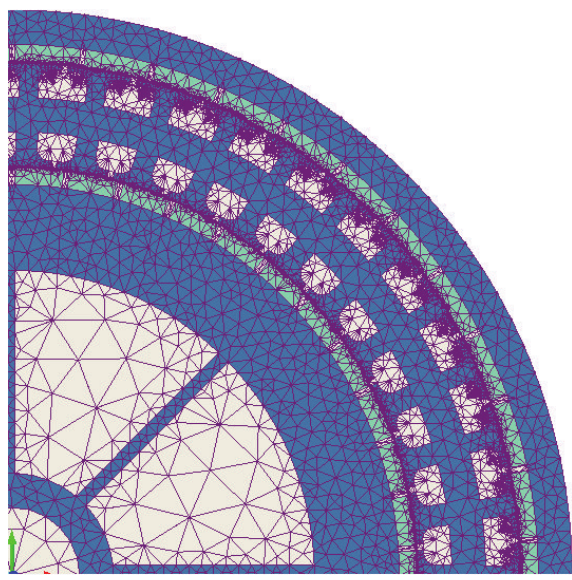
Figure 3: A section of DRFPMG FEM